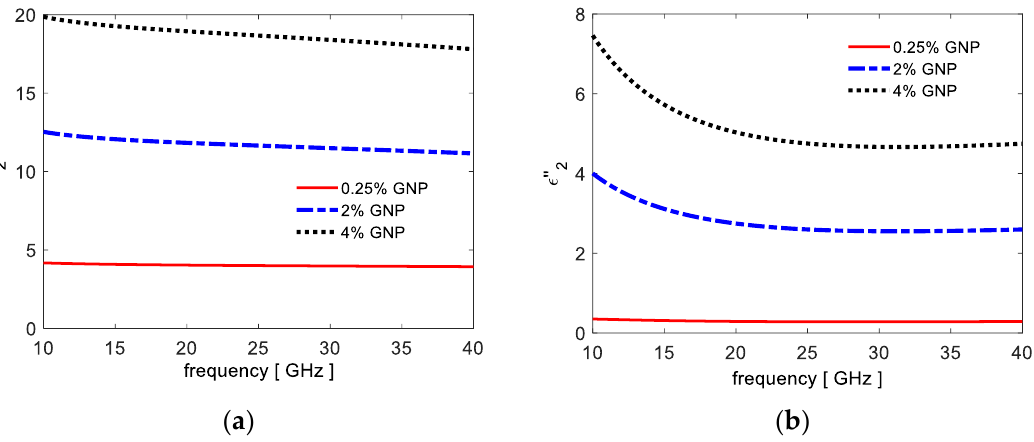
Figure 2. Frequency spectra of the real ( a ) and imaginary ( b ) parts of the permittivity of the graphene based composite employing different amounts of GNPs.